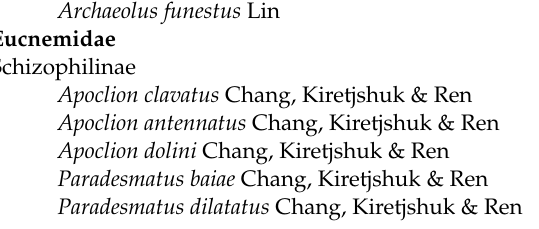
Table A1. List of Chinese Mesozoic clicking